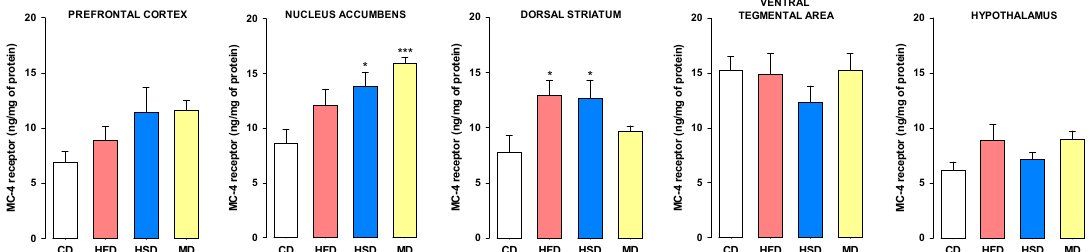
Figure 2. Effects of maternal diet during pregnancy and lactation on melanocortin-4 (MC-4) receptor expression in the synaptosomal fraction of the prefrontal cortex, nucleus accumbens, dorsal striatum, ventral tegmental area, and hypothalamus in female offspring rats at PND 63. The results are expressed as the mean (±SEM). n = 8 rats/group. Data were analyzed by one-way analysis of variance (ANOVA) followed by Dunnett’s post hoc test. * p < 0.05, *** p < 0.001 versus the control diet (CD) group. HSD, high-sugar diet; HFD, high-fat diet; MD, mixed diet.